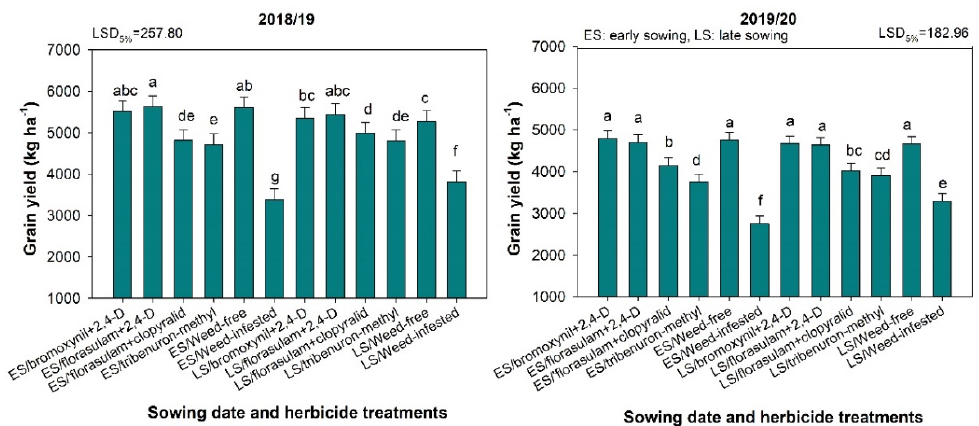
Figure 4. Grain yield (kg ha − 1 ) as affected by the sowing date (early and late sowing) and the herbicide treatments (bromoxynil + 2.4-D, florasulam + 2.4-D, florasulam + clopyralid, tribenuron-methyl, weed-free, and weed-infested). Means followed by the same letters do not significantly differ with Fisher’s least significant difference (LSD) test. Error bars indicate the LSD values.